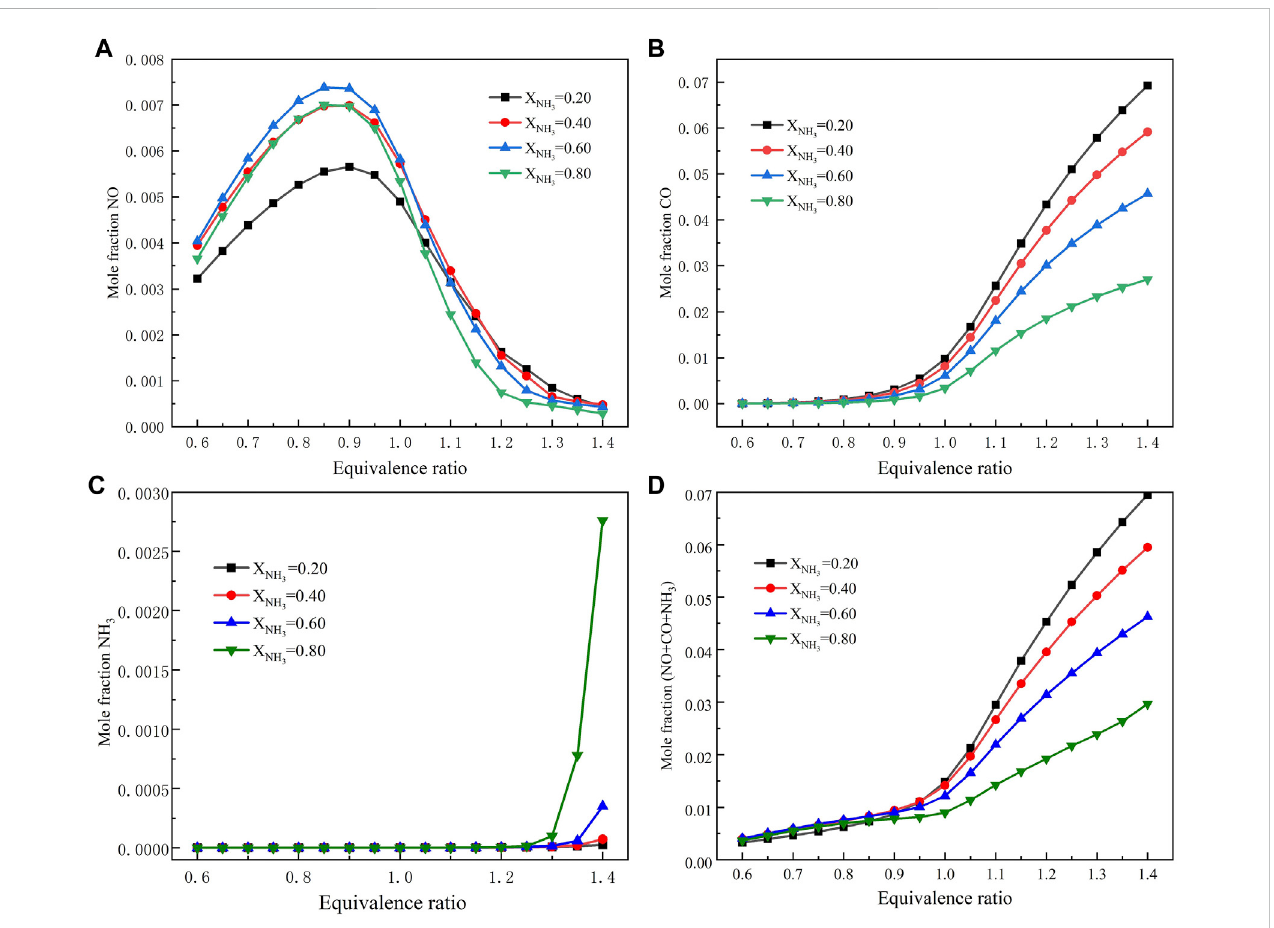
FIGURE 5 Emission of major pollutants as a function of equivalent ratio: (A) NO emission; (B) CO emission; (C) NH 3 emission; (D) Emission of total